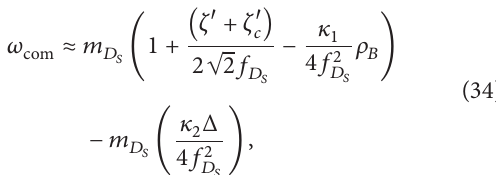
Figure 6: The optical potentials of the (a) 𝐷 + 𝑆 and (b) 𝐷 − 𝑆 mesons, as a function of momentum 𝑘 ( ≡| matter, at different values of 𝜌 𝐵 . In each case, the hyperonic matter situation ( 𝑓 𝑠 = 0.5 ), as described in the legend, is also compared against the nuclear matter ( 𝑓 𝑠 = 0 ) situation, represented by dotted